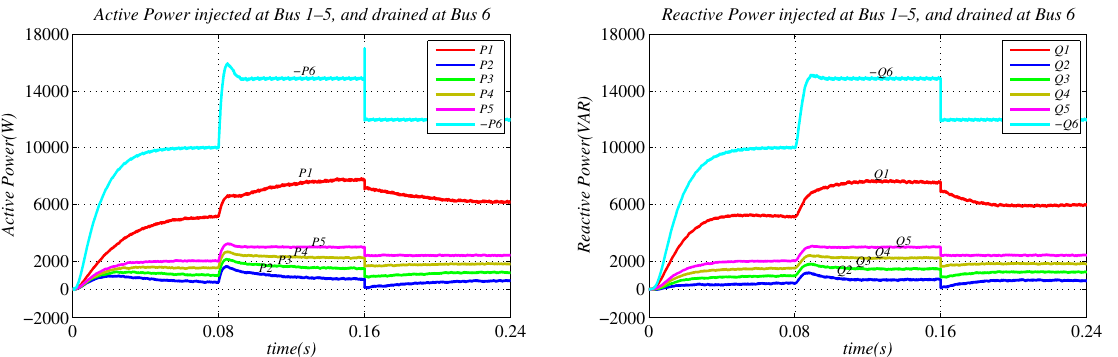
Figure 23. Active power and reactive power injected at Buses 1–5, and drained at Bus 6 (six-bus